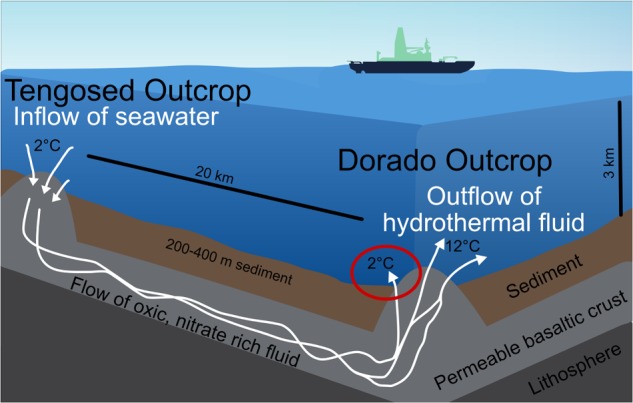
Schematic of the cool hydrothermal system (CHS) at Dorado Outcrop. Seawater enters the crust through recharging outcrops, such as Tengosed, 20 km distance from Dorado Outcrop. This cool seawater flows through the crust for <3 years before discharging at Dorado Outcrop (Wheat et al., 2017). The red circle denotes the focus of this study, the sediments on and near Dorado Outcrop which experience hydrothermal fluid discharge.